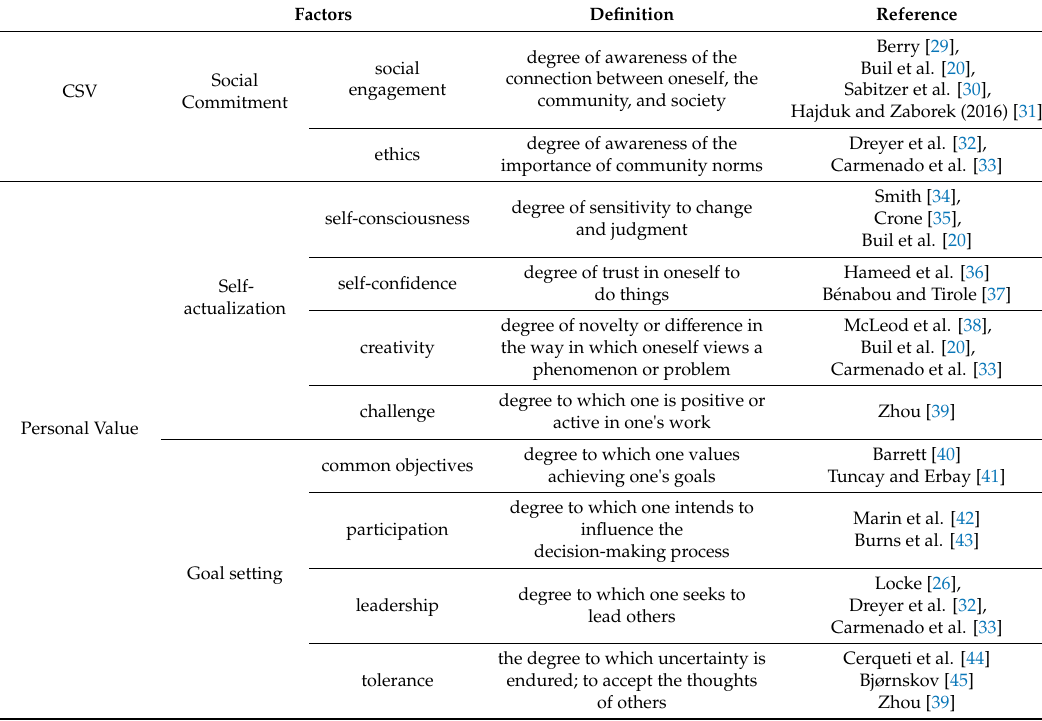
Table 1. Factors of CSV and Personal